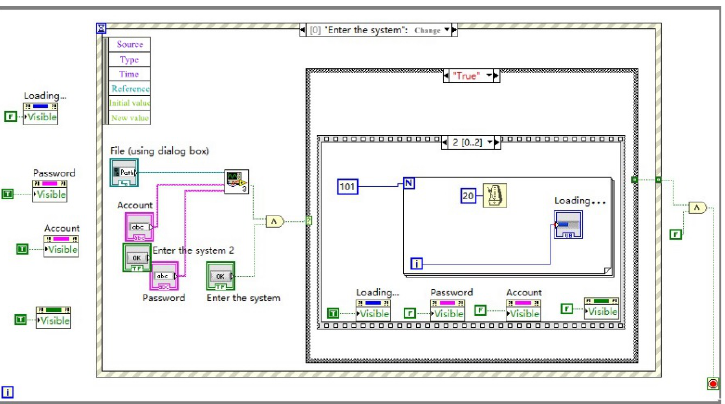
Figure 7. Main program block diagram of the login interface .